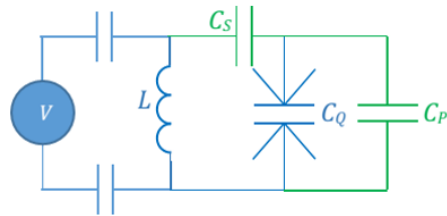
Figure 2. Illustration of the basic capacitive quantum bit design. The addition of series and parallel extra capacitors adds up to the design